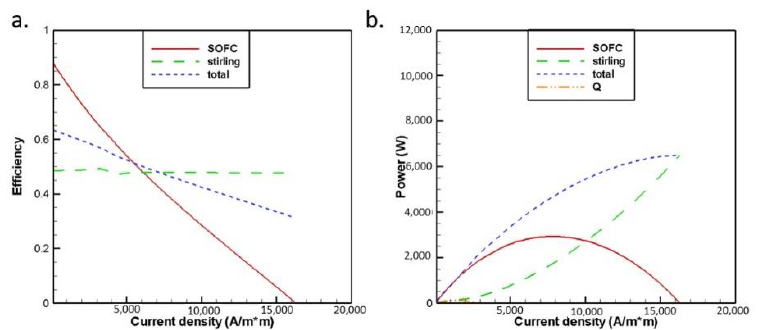
Figure 7. Computed ( a ) efficiency and ( b ) generated power for different current densities at 873 K for the hybrid SOFC-SE system with heat components.